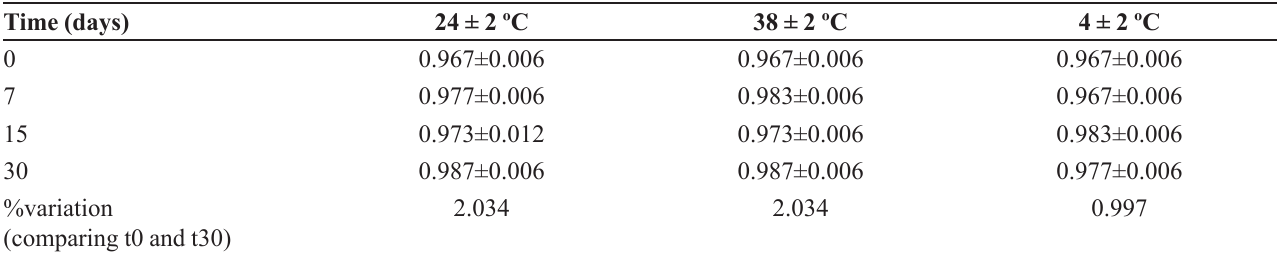
TABLE V - Relative density values (g/cm 3 ) measured periodically, for 30 days, for the formulation containing GB extract (mean ± standard deviation). The percentage of variation comparing t0 and t30 is